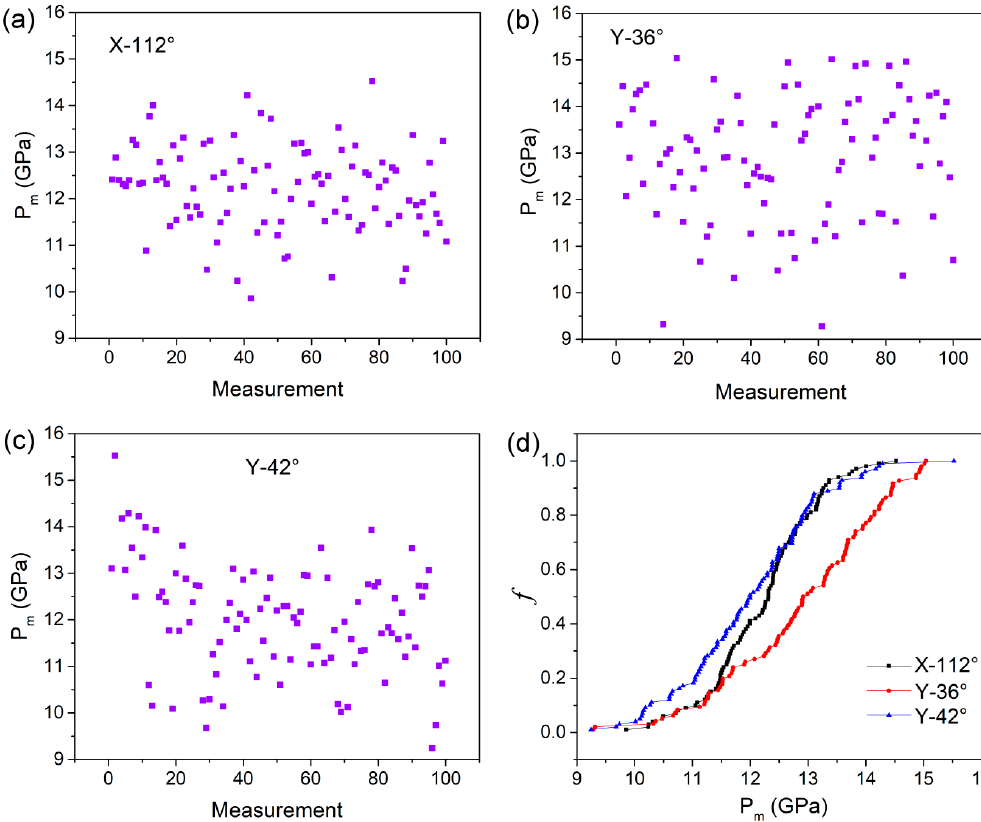
Table 1. Mean pressure, yield stress, and activation volume for three planes.